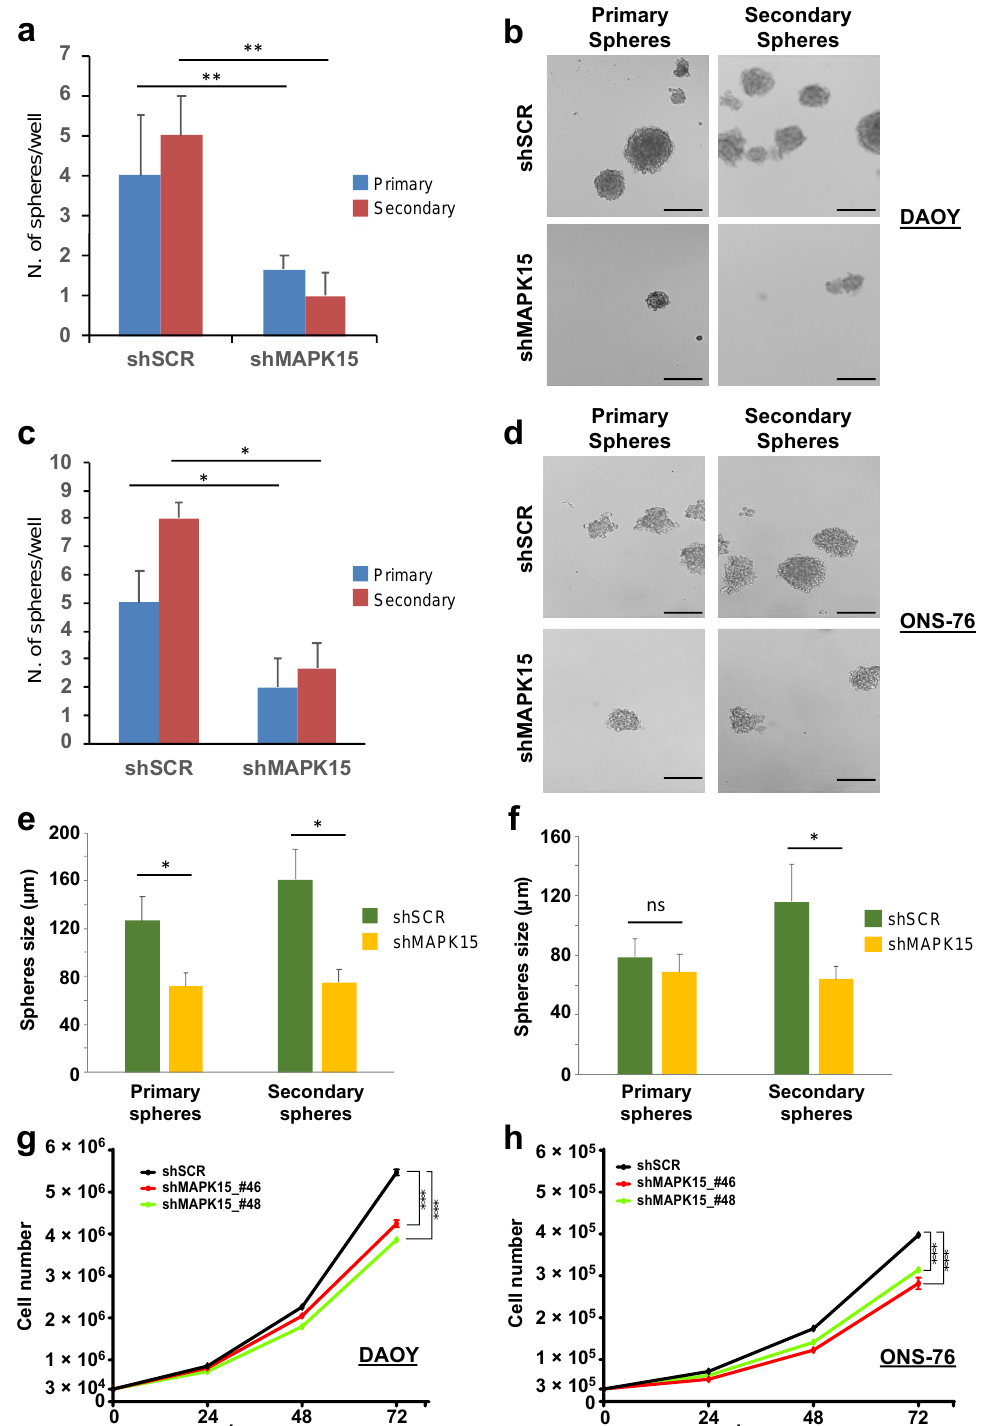
Figure 4. MAPK15 controls the enrichment of the medulloblastoma stem cell compartment. Number ( a , c ) and representative images ( b , d ) of primary and secondary spheres in DAOY ( a , b ) and ONS-76 ( c , d ) cells stably transduced with scrambled (shSCR) or MAPK15 (shMAPK15) shRNAs. ( e , f ) Size of primary and secondary DAOY ( e ) and ONS-76 ( f ) spheres transduced, as indicated. Scale bar = 150 µ m. DAOY ( g ) and ONS-76 ( h ) cells (3 × 10 4 ), stably transduced with scrambled (shSCR, negative control) or two different MAPK15 shRNA (shMAPK15_#46 or shMAPK15_#48), were seeded in 12-well plates and then harvested at indicated time-points (24, 48 and 72 h) and counted. *, p < 0.05; **, p < 0.01; ***, p < 0.001; ns, not significant. 3.5. MAPK15 effects on the Hedgehog pathway depends on the ability of the kinase of affecting ciliary structures.